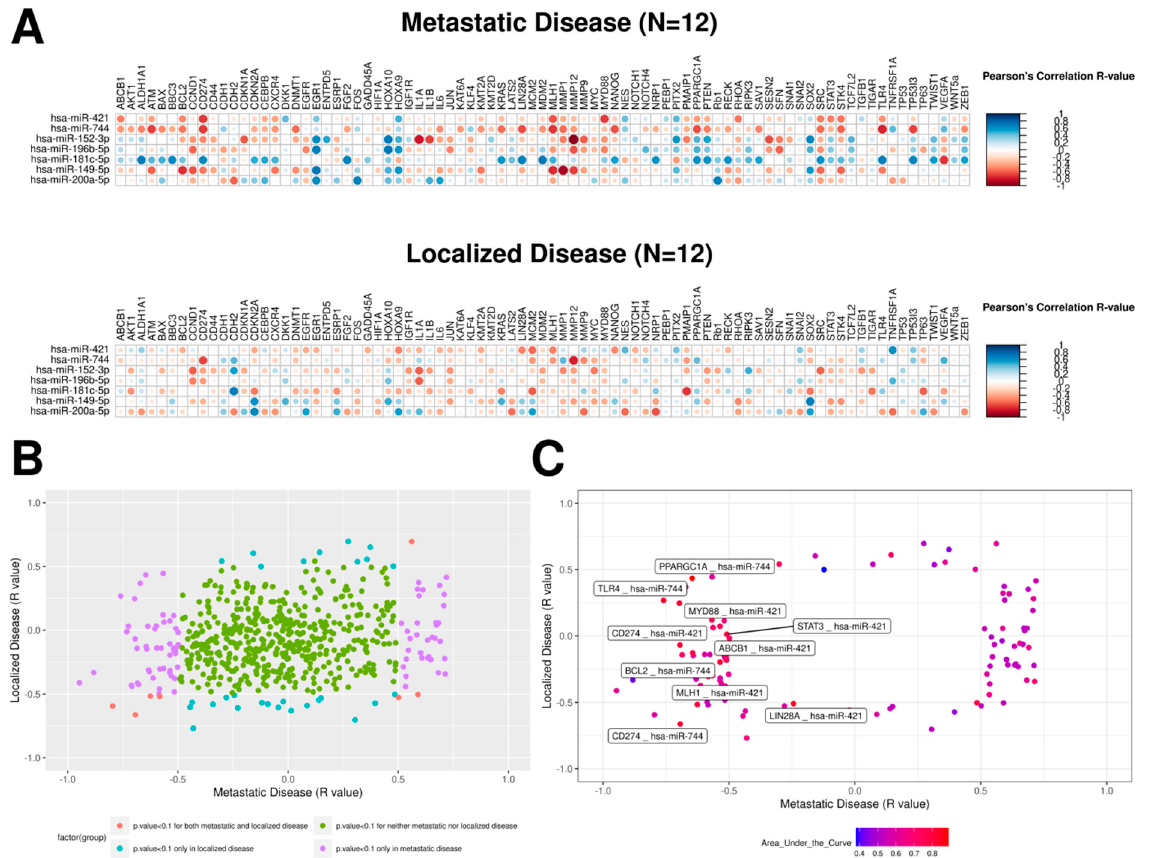
Figure 1. Pair-wise correlations between expression levels of seven miRNAs and 83 genes in tumors of patients with metastatic and localized disease in the total sample of 24 PeC patients. ( A ) Pearson correlation coefficients between the expression levels of miRNAs and mRNAs showed different profiles across metastatic and localized diseases. The size and color of each dot represent the Pearson correlation R-values for each combination of mRNA–miRNA pairs; ( B ) Scatter plot for all mRNA–miRNA pair-wise ratios in metastatic and localized tissues. Each dot was colored according to the p -value for each tissue; ( C ) Scatter plot for mRNA–miRNA pairs with significant correlations in at least one tissue. Dots are colored according to their Area Under the Curve (AUC) values for discrimination of metastatic ( n = 12) and localized tumor ( n = 12) samples.